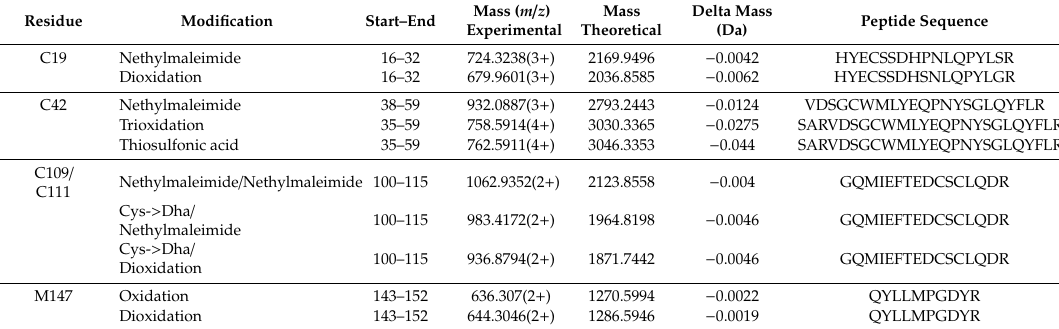
Figure 6. The relative intensity of precursor ion peptide containing modifications in WT and P24S / S31G mutant γ D-crystallin ( a – f ). The relative intensity of precursor ion unmodified and oxidized peptide including ( a ) Cys19, ( b ) Cys42, ( c ) Cys109 and 111, ( d – f ) Met147 with WT (white bar) and P24S / S31G mutant (black bar). NEM means NEM ( N -ethylmaleimide) adducts of Cys residue that is not oxidized. Total ion chromatogram (TIC) intensity of sample as control normalize each intensity of modifications. Each experiment was repeated twice. Table 2. Post-translational modifications detected in recombinant protein WT and double mutant (P24S / S31G) of γ D-crystallin. Peptides with the highest ion scores for each spot were tabulated. Modified residues are highlighted in bold. MS / MS spectra of modified peptides are presented in Figure S8.